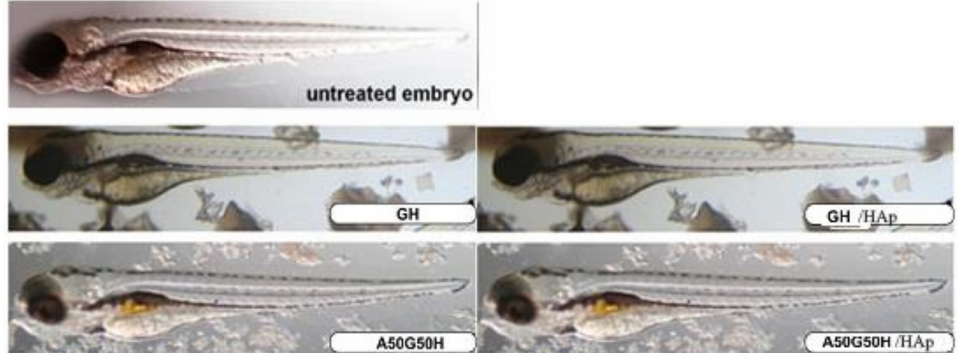
Figure 8. Morphology of zebrafish embryos exposed to the ground materials GH, GH/HAp, A50G50H, and A50G50H/HAp hydrogel scaffolds (200 µ g/mL) at 104